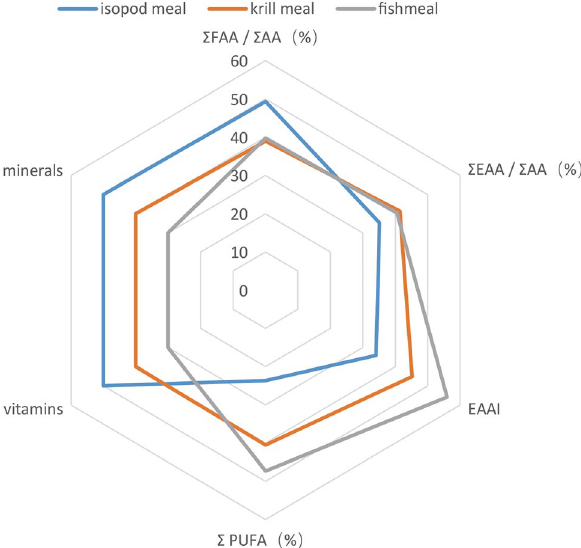
Figure 6. A radar chart illustrating the comprehensive nutritional evaluation of isopod meal, krill meal and fishmeal. Factors of ΣFAA/ΣAA(%),ΣEAA/ΣAA(%), EAAI andΣPUFA were scored based on the actual values from Tables 2, 3 and 4. For other two factors, three food materials are ranked based on the top rank having the highest value in the number of parameters, followed by the second and third respectively. For example, isopod substrate has six highest parameters in the mineral category, followed by krill with two and fishmeal one (Table 6), so they are ranked first, second and third respectively. To facilitate comparison with other